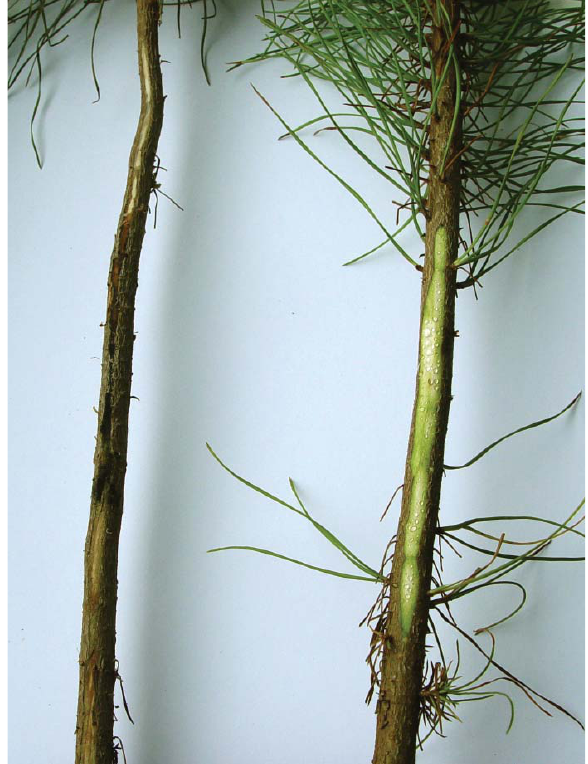
Fig. 2. Stem necrotic lesion caused by Diplodia pinea on Pinus radiata seedling (left) and an asymptomatic control seedling